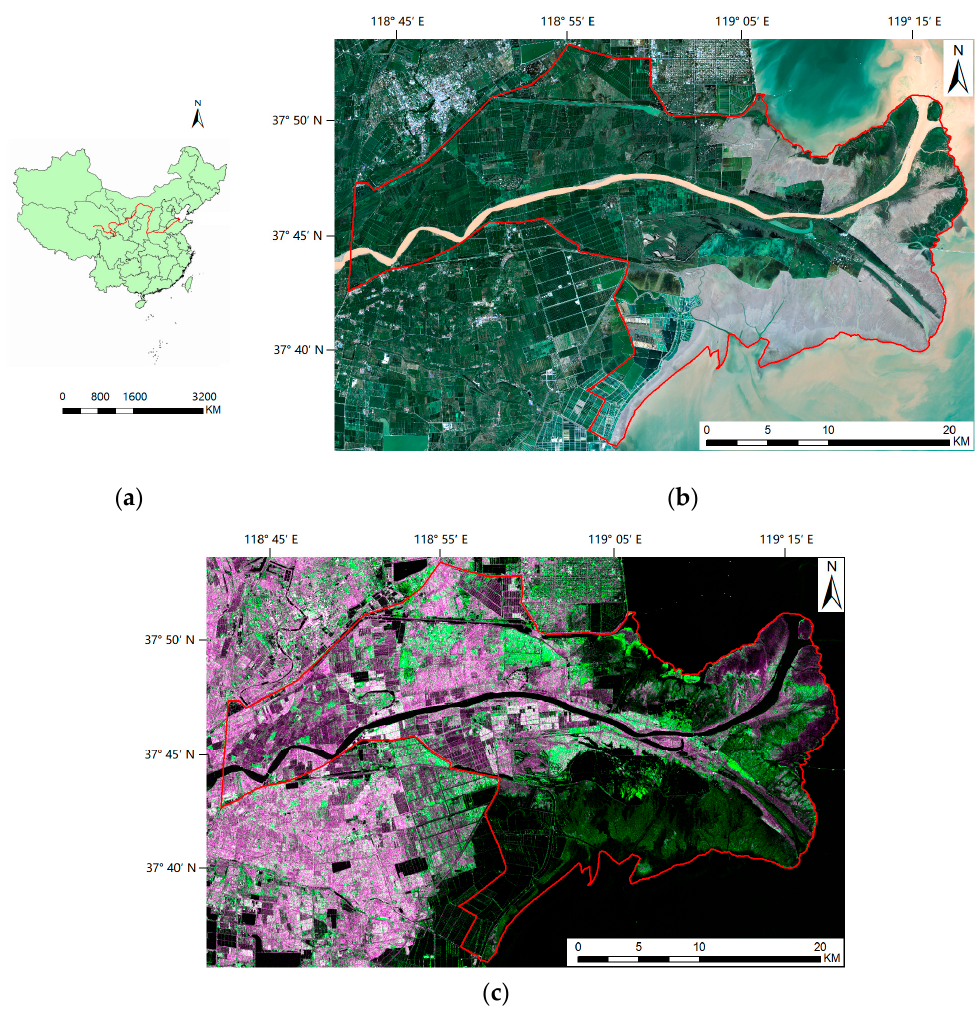
Figure 1. Study area. ( a ) Yellow River of China; ( b ) True color image of Sentinel-2 on 25 August 2018; and ( c ) False color image of Sentinel-1 (Red: VH, Green: VV, Blue: VH) on 26 August 2018. Table 1. Classification scheme of the Yellow River